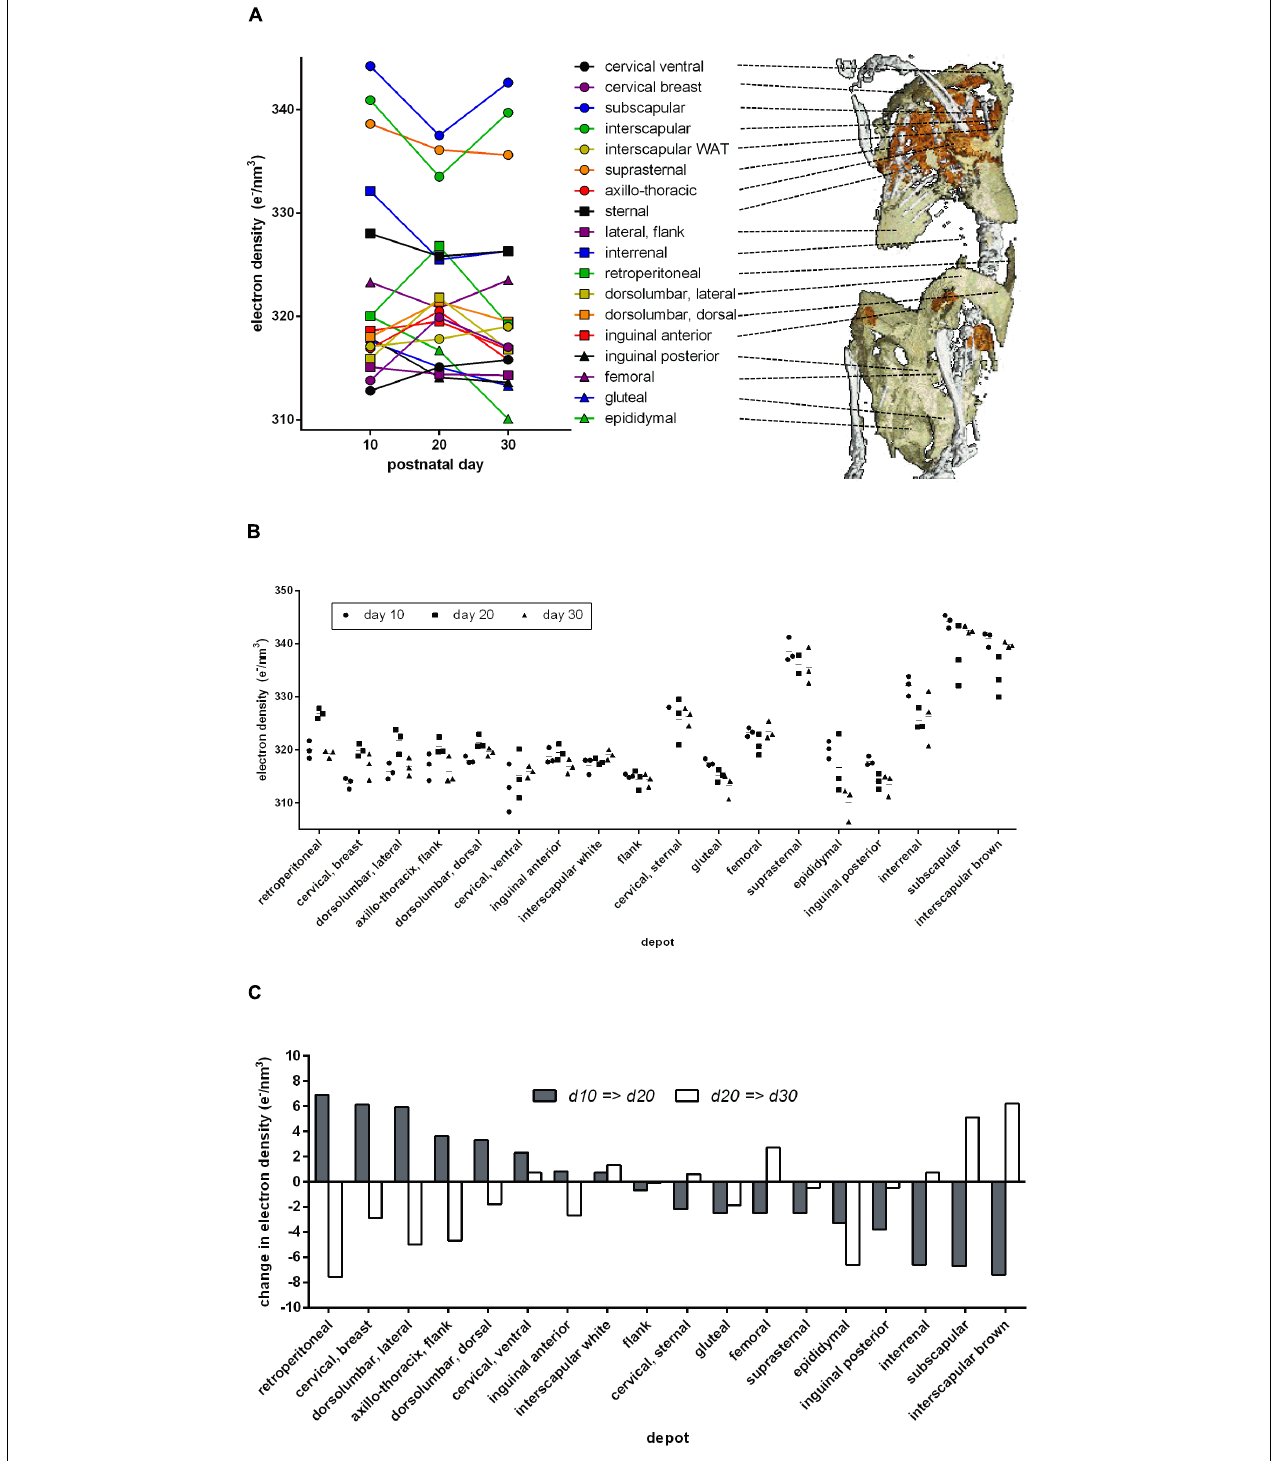
FIGURE 3 | Electron density and anatomical location of 18 defined adipose tissues at three time points after birth. (A) Dots indicate mean values of three individuals, and individual values are given in B . Lines connect the respective depot along the time axis. The 3D anatomical model underlying the snapshot shown here is available as a download in the supplement. (B) Individual electron densities at three time points after birth, n = 3. Anatomical location as outlined in A . (C) Change in mean electron density from day 10 to 20 (gray bars) and from day 20 to 30 (white bars). Some adipose tissues transiently “brown” at day 20 (gray bar positive, white bar negative, e.g., retroperitoneal), while others “whiten” (gray bar negative, white bar positive, e.g., subscapular).